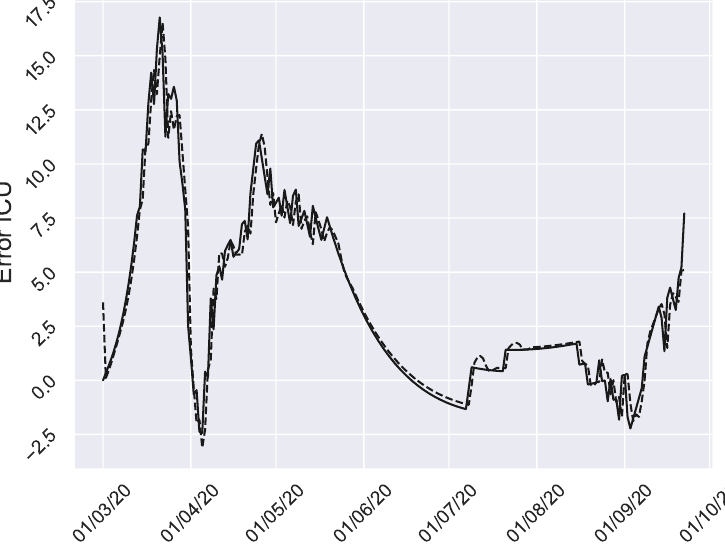
Figure A1. Residuals of ICU. Solid line are the actual residuals and the dashed line is the AR